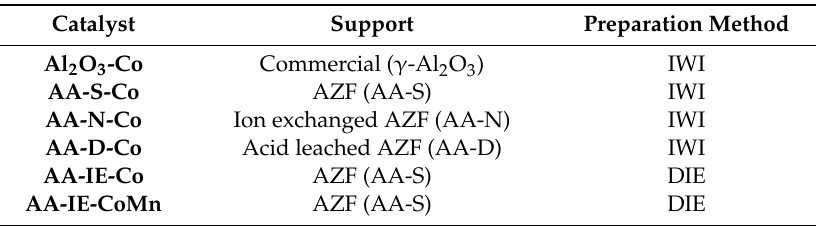
Table 8. Prepared catalysts